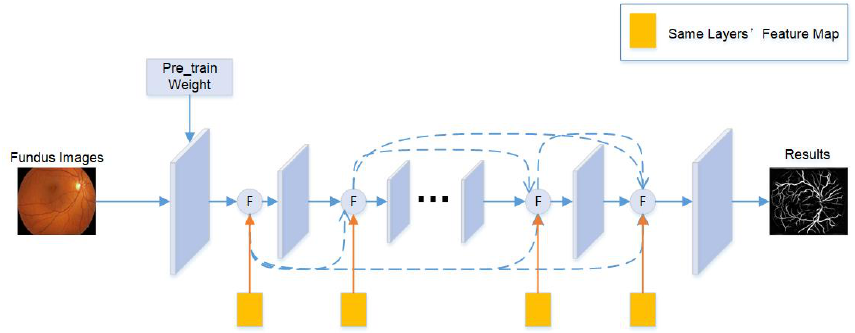
Figure 1. Vessel segmentation network for fundus images based on aggregation